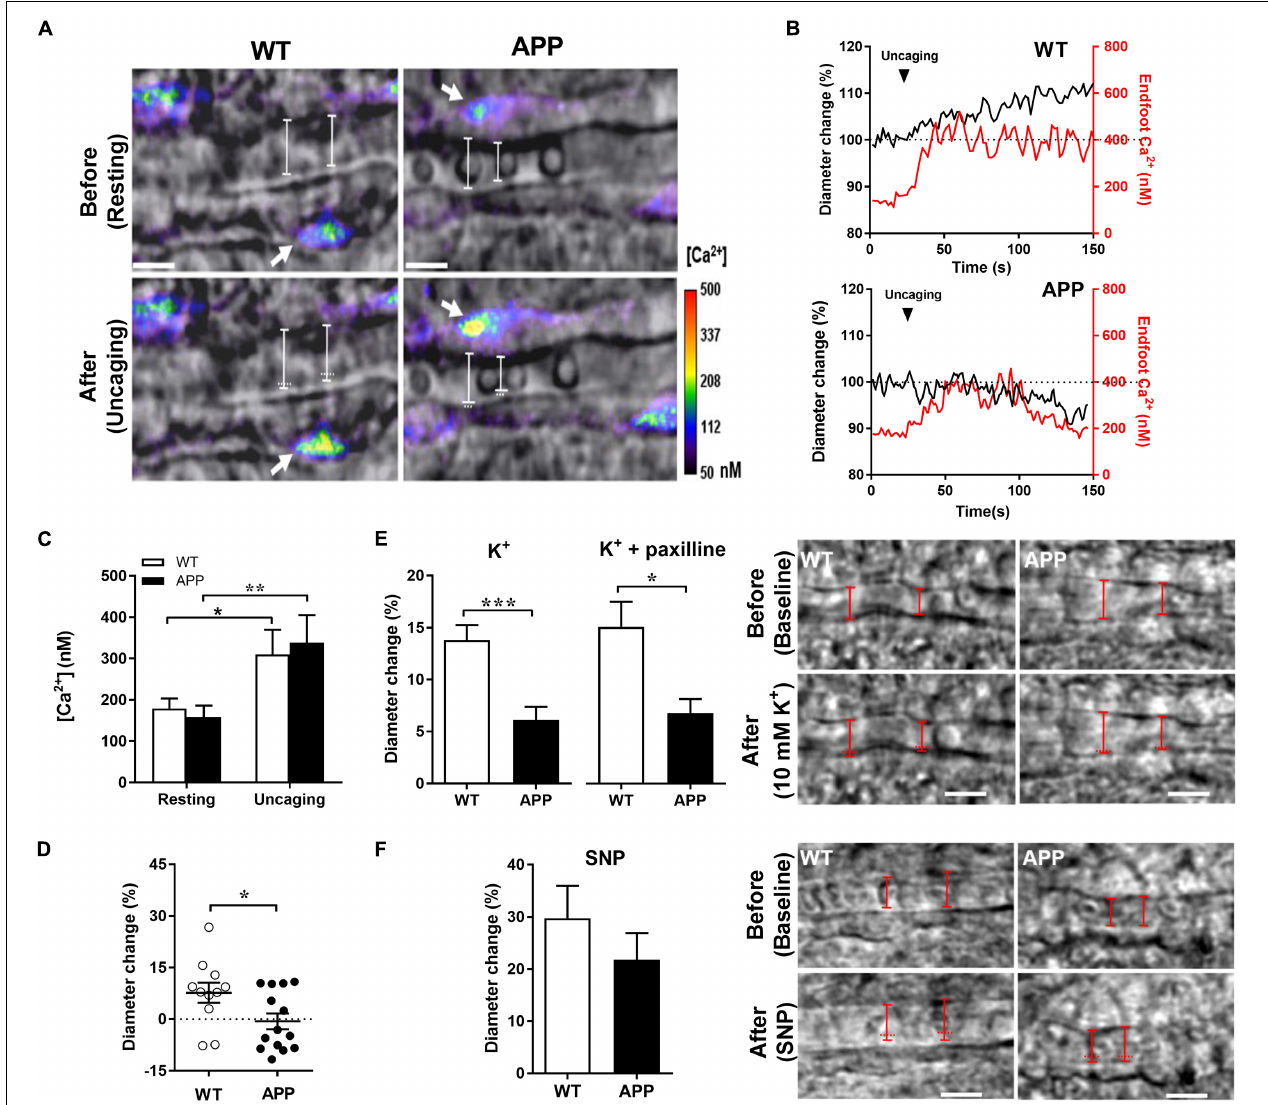
FIGURE 4 | Impaired gliovascular coupling in the hippocampal slices of APP mice. (A) Infrared differential interference contrast (IR-DIC) images before (resting) and after two photon photolysis of caged Ca 2 + within an astrocyte endfoot surrounding arterioles in hippocampal slices. Ca 2 + uncaging was achieved in slices loaded with DMNP-EDTA (10 µ M, 60 min) by scanning a region of interest within an endfoot at a higher (6 × ) laser intensity for ∼ 0.5 s. The resulting elevations in endfoot Ca 2 + (range, 200–500 nM) caused arteriole dilation in slices from WT controls but constriction in slices from APP mice. Arrows indicate target endfeet of Ca 2 + uncaging. The vascular diameter is labeled by white solid lines whereas white horizontal dots indicate the previous position of the vessel wall before Ca 2 + uncaging (Scale bars, 10 µ m). (B) Time course traces of changes in endfoot Ca 2 + (red) and arteriole diameter (black) in response to Ca 2 + uncaging in WT and APP mice. (C) Astrocytic endfoot Ca 2 + before (resting) and at its peak after Ca 2 + uncaging and (D) the percentage of changes in arteriolar diameter evoked by Ca 2 + uncaging in the same group of hippocampal slices from WT and APP mice. (E) Vascular response to 10 mM K + perfusion in hippocampal slices from APP mice pre-incubated or not with paxilline (1 µ M) (left panel). Infrared differential interference contrast (IR-DIC) images before (baseline) and after a 10 mM K + perfusion of an hippocampal arteriole from WT and APP mice. The vascular diameter is labeled by red solid lines whereas the horizontal red dots indicate the pre-K + incubation position of the vessel wall (right panel, scale bars, 10 µ m). (F) Sodium nitroprusside (SNP) induced a small, non-significant decrease of arteriole dilation in slices of APP mice (left panel). Infrared differential interference contrast (IR-DIC) images before (baseline) and after SNP perfusion of an hippocampal arteriole from WT and APP mice. The vascular diameter is labeled by red solid lines whereas the horizontal red dots indicate the Pre-SNP incubation position of the vessel wall (right panel, scale bars, 10 µ m). (C) * p < 0.05, ** p < 0.01; two-way ANOVA repeated measures followed by Bonferroni correction, n = 6–8; (D,E) * p < 0.05, *** p < 0.001; two-tailed unpaired t -test, n =